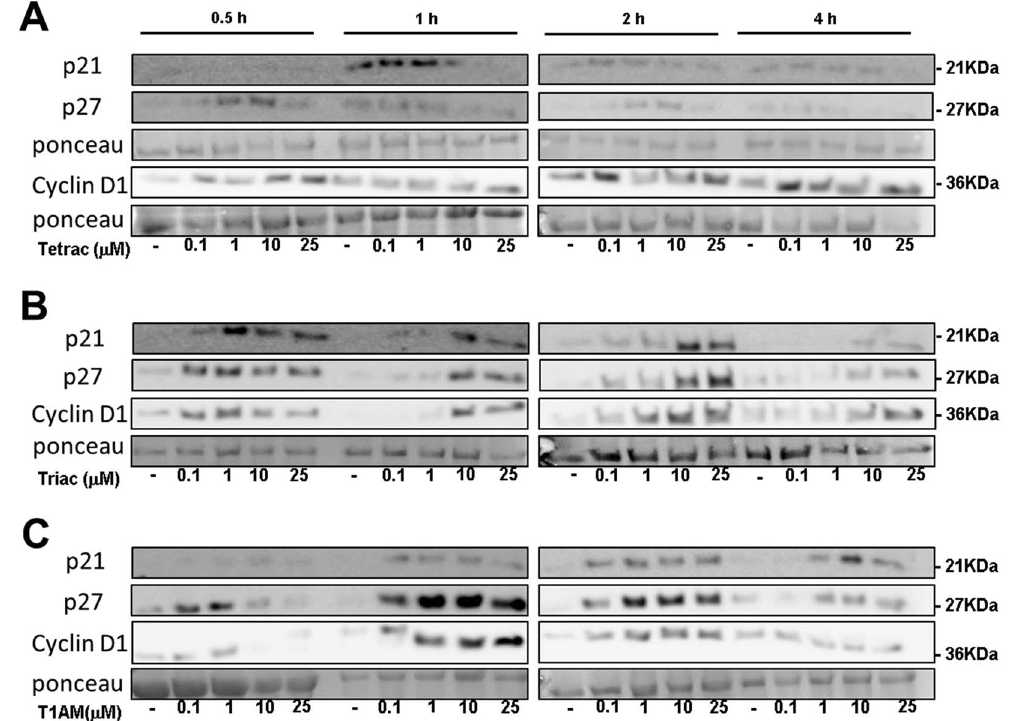
Figure 2. Thyroid hormone derivatives induce cell cycle regulators. OVCAR3 cells were treated for 0.5–4 hours with 0.1, 1, 10 or 25 μ M ( A ) tetrac ( B ) triac and ( C ) T1AM, respectively. Protein levels of p21, p27 and cyclin D1 were analyzed by Western blots. Representative blot of two independent experiments is